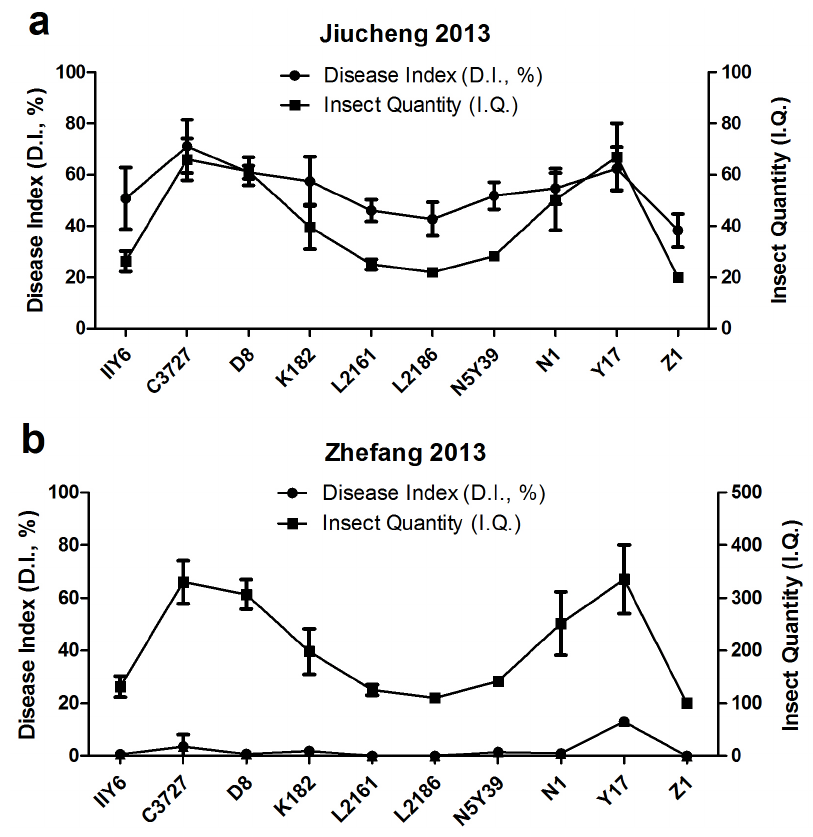
Figure 5. Field tests in 2013. ( a ) Relationship between the disease index (D.I.) and insect quantity per 100 clusters (I.Q.) of 10 rice cultivars in Jiucheng village. ( b ) Relationship between the disease index (D.I.) and insect quantity per 100 clusters (I.Q.) of 10 rice cultivars in Zhefang village.